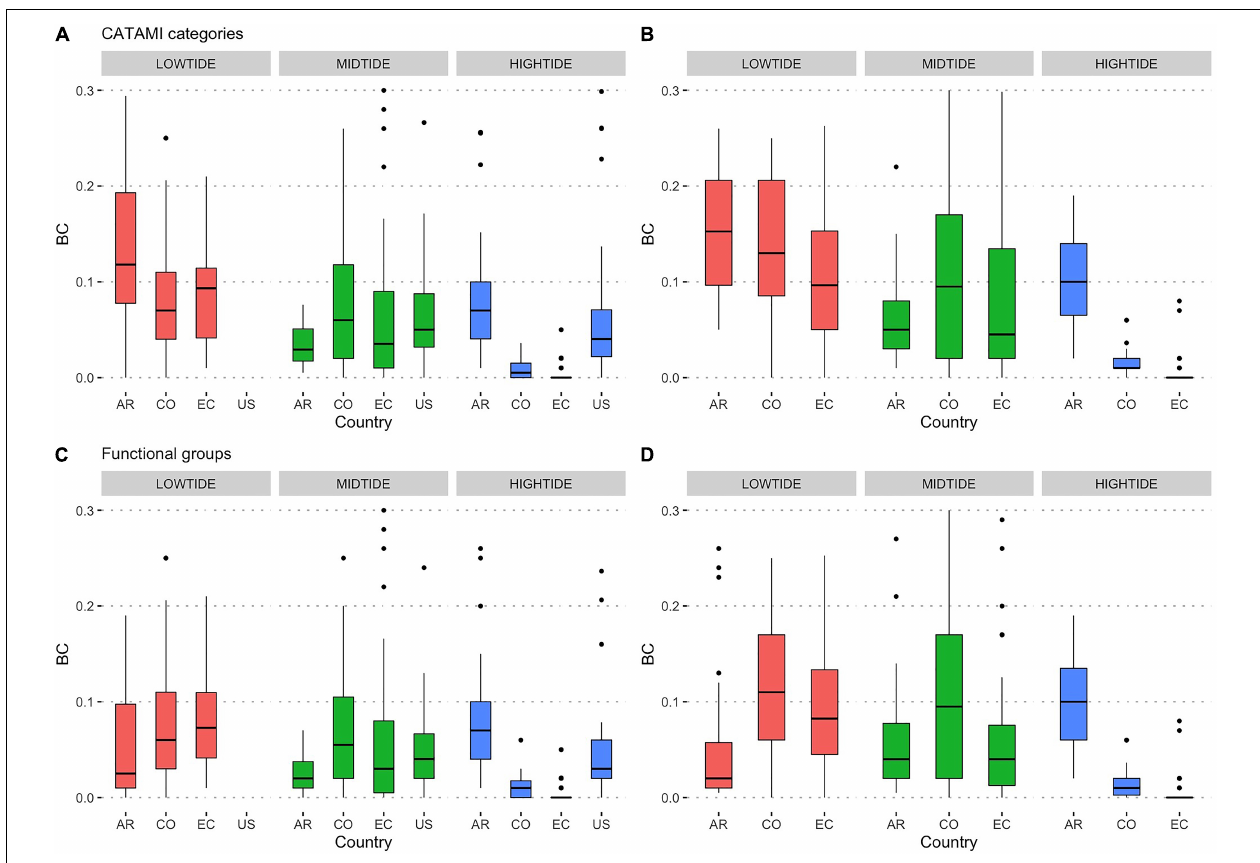
FIGURE 4 | Boxplot of Bray-Curtis distances between the two methods (A,C) PQ.human vs. PQ.robot and (B,D) VQ vs. PQ.robot. (A,B) CATAMI categories, (C,D) functional groups. AR, Argentina, CO, Colombia; EC, Ecuador; US, United States. The horizontal bar inside bars represents the median, the lower and upper boxes represent the 25th and 75th percentiles, and the whiskers the 5th and 95th percentiles. Black dots represent outliers values above the 95th percentile.